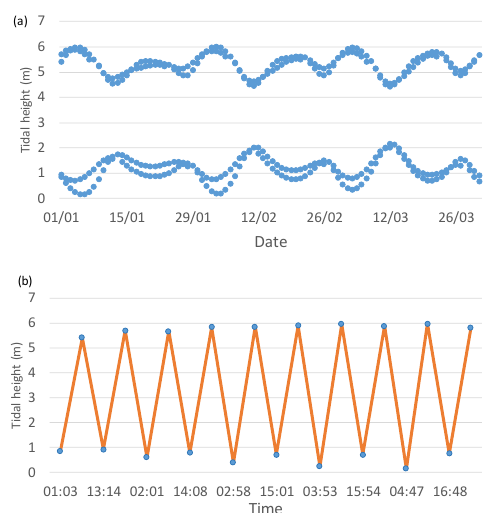
Fig. 1. Tidal currents velocity and depth along the Chubut coast. The red points mark the places where tidal currents velocity and depth are known [20, 21]. Find references of this Fig. in Table I.